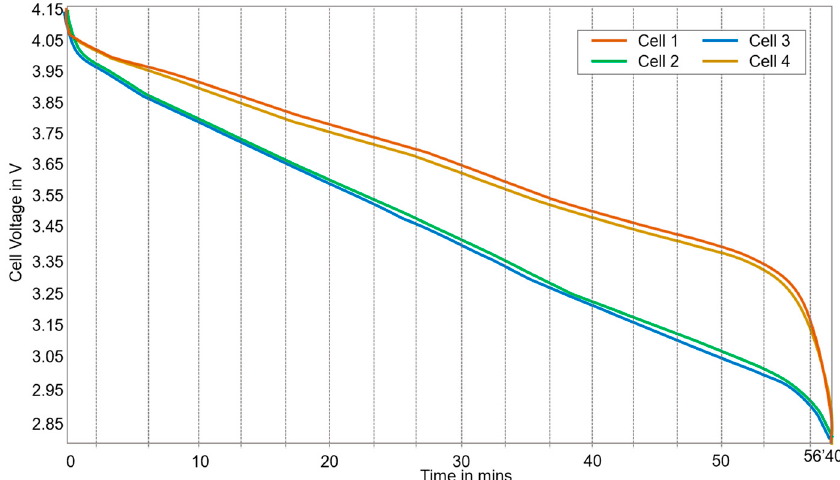
Figure 7. Voltage discharging profile at the 400th cycle.